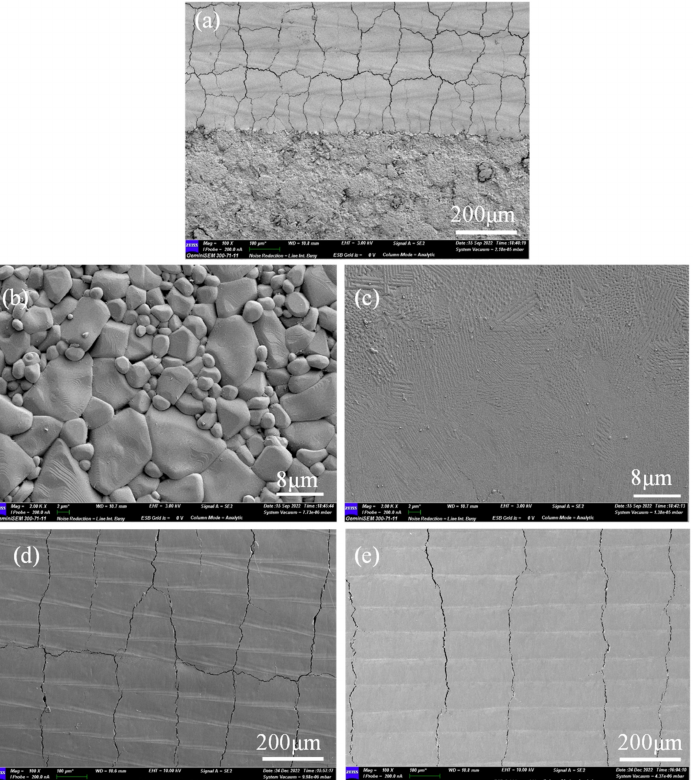
Figure 6. SEM images of the surface before and after laser polishing. ( a ) 1#, polished at normal temperature, ( b ) local magnification of the original surface of alumina, ( c ) local magnification of the polished surface at normal temperature, ( d ) 2#, preheated at 450 ◦ C, ( e ) 3#, preheated at 900 ◦